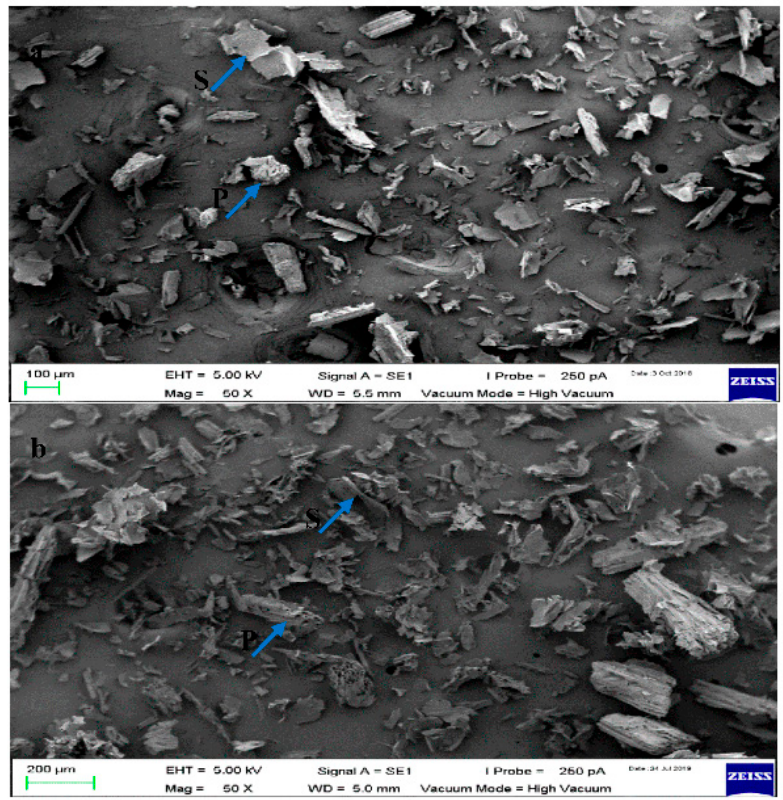
Figure 2. ( a ) General view of the RSCB sample shows the fibers (outer surface) and pith (inner surface), (arrows S and P). ( b ) General view of the TSCB sample shows the fibers (outer surface) and pith (inner surface), (arrows S and P).